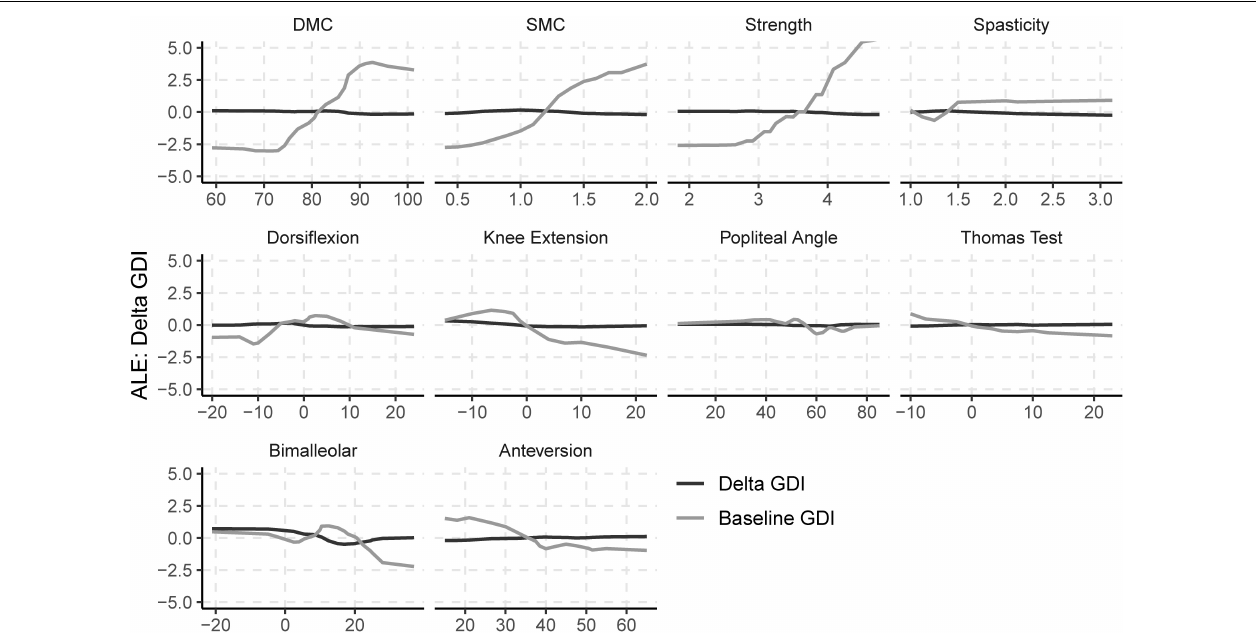
FIGURE 3 | Accumulated local effects (ALE) of baseline neurologic and orthopedic impairments on GDI pre and (cid:49)